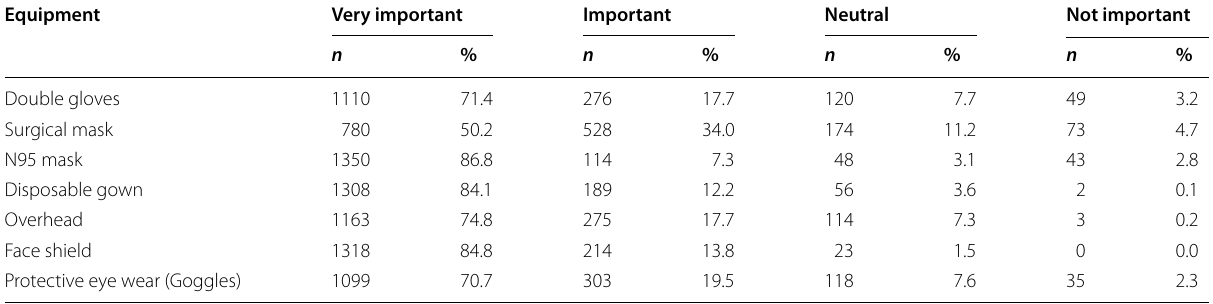
Table 5 Frequencies ( n ) and percentages (%) for important PPE items that help dentists feel safe during dental treatment in the time of COVID-19 pandemic